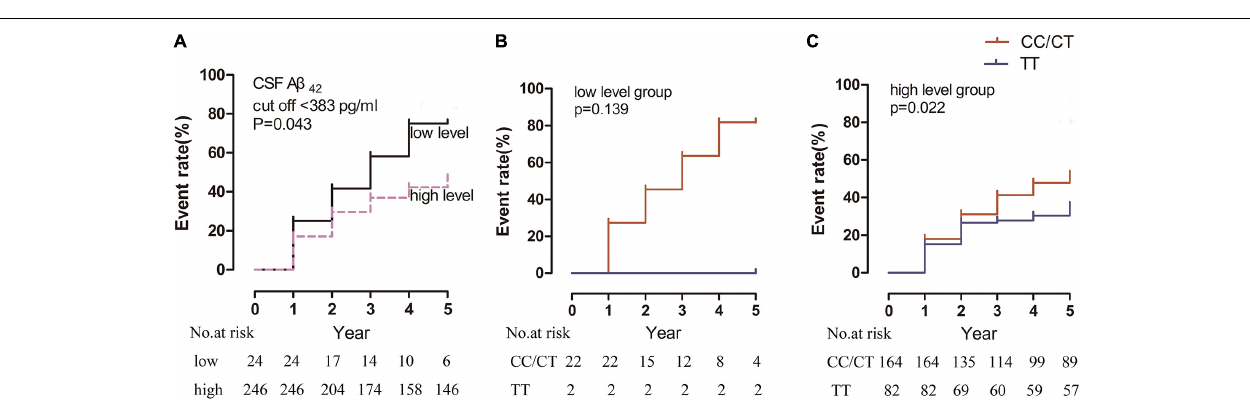
FIGURE 4 | Kaplan-Meier estimates showing the cumulative risk of RBD based on A β 42 levels in the (A) “low-level” and “high-level” groups, (B) rs3910105 C and non-carriers in the “low-level” group, and (C) rs3910105 C carriers and non-carriers in the “high-level” group. In panel (A) , the black line indicates the “low-level” group, and the dashed purple line indicates the “high-level” group. In panels (B,C) , red lines indicate rs3910105 C carriers, and blue lines indicate